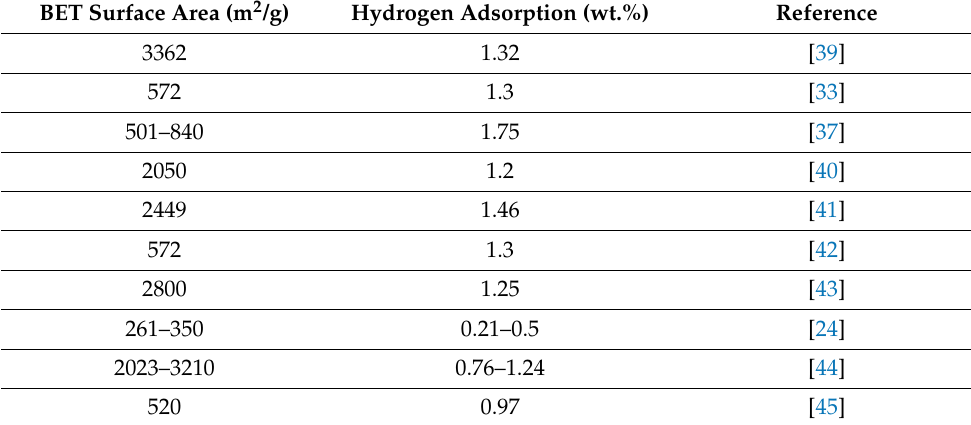
Table 2. BET surface area and hydrogen adsorption capacity (at 77 K and 1 bar) of MOF-5. BET Surface Area (m 2 /g) Hydrogen Adsorption (wt.%)